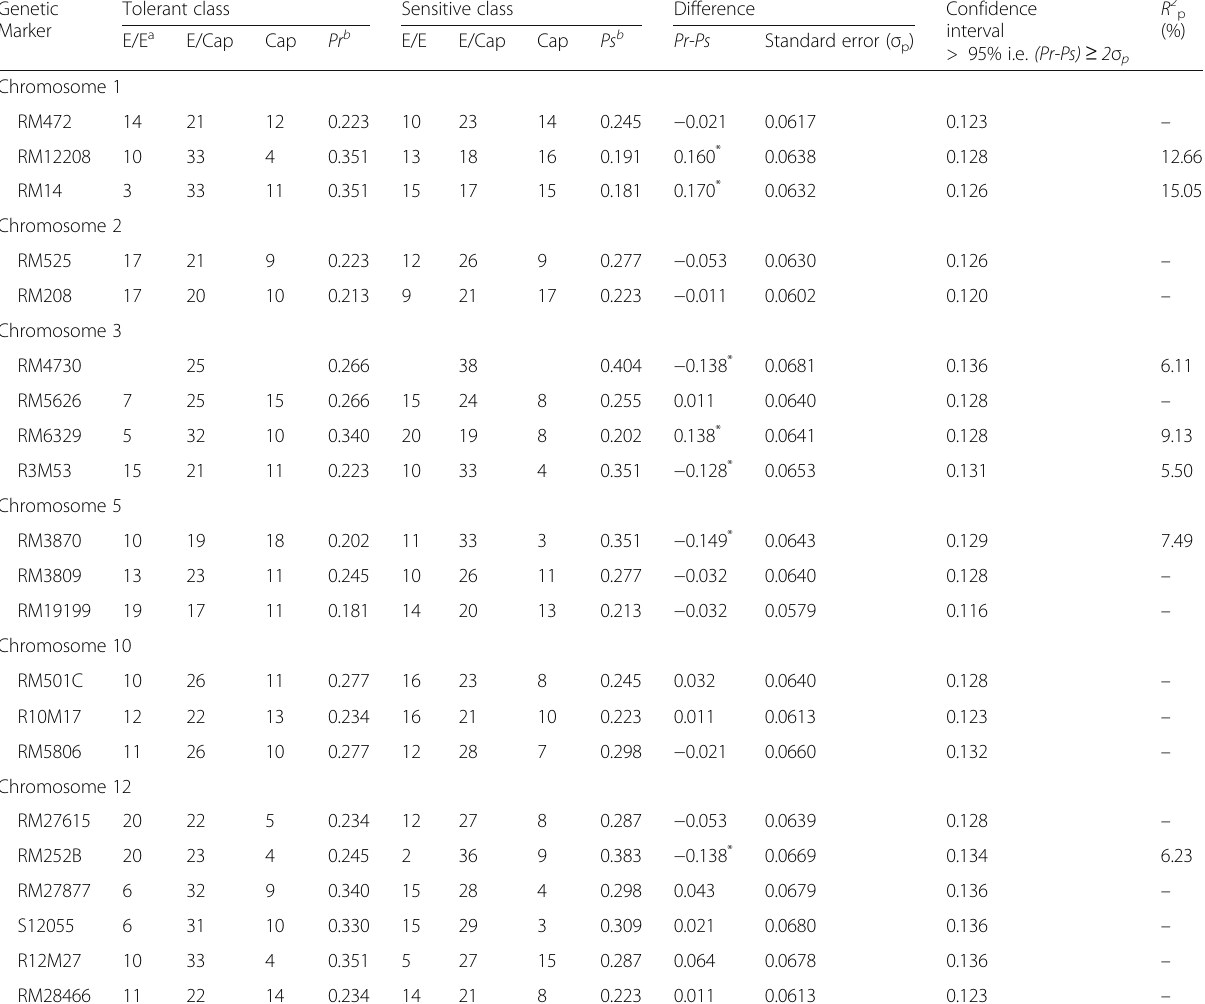
Table 4 Segregation of SSR and InDel markers that exhibited association with QTL for salinity tolerance in selected salt-tolerant and salt-sensitive classes in an F 2 population of a cross between Capsule (tolerant) and BR29 (sensitive) genotypes. A negative sign of the allele frequency difference between the tolerant and sensitive classes ( Pr-Ps ) indicates allele-frequency changes in the opposite direction to the parental phenotype Genetic